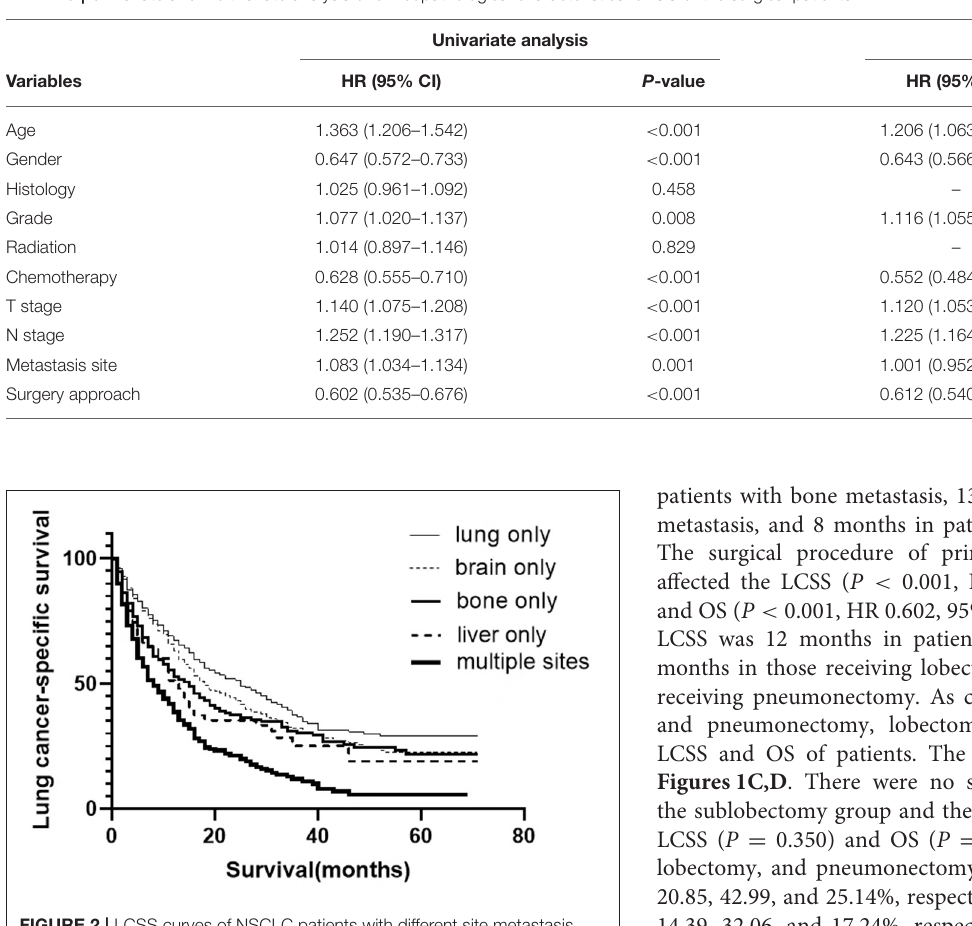
FIGURE 2 | LCSS curves of NSCLC patients with different site metastasis after primary surgery.